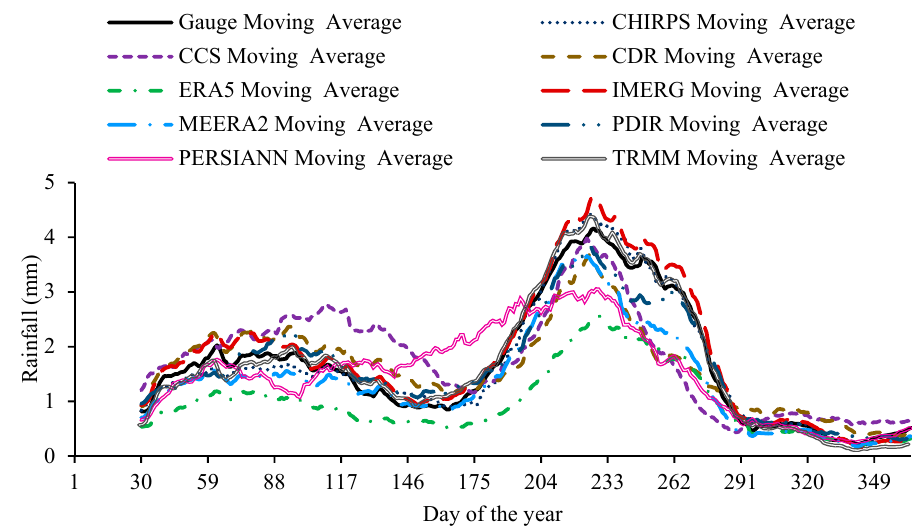
Figure 5. Temporal discrepancy in the daily average precipitation amount obtained from reference gauge stations and all reanalysis and SPPs.